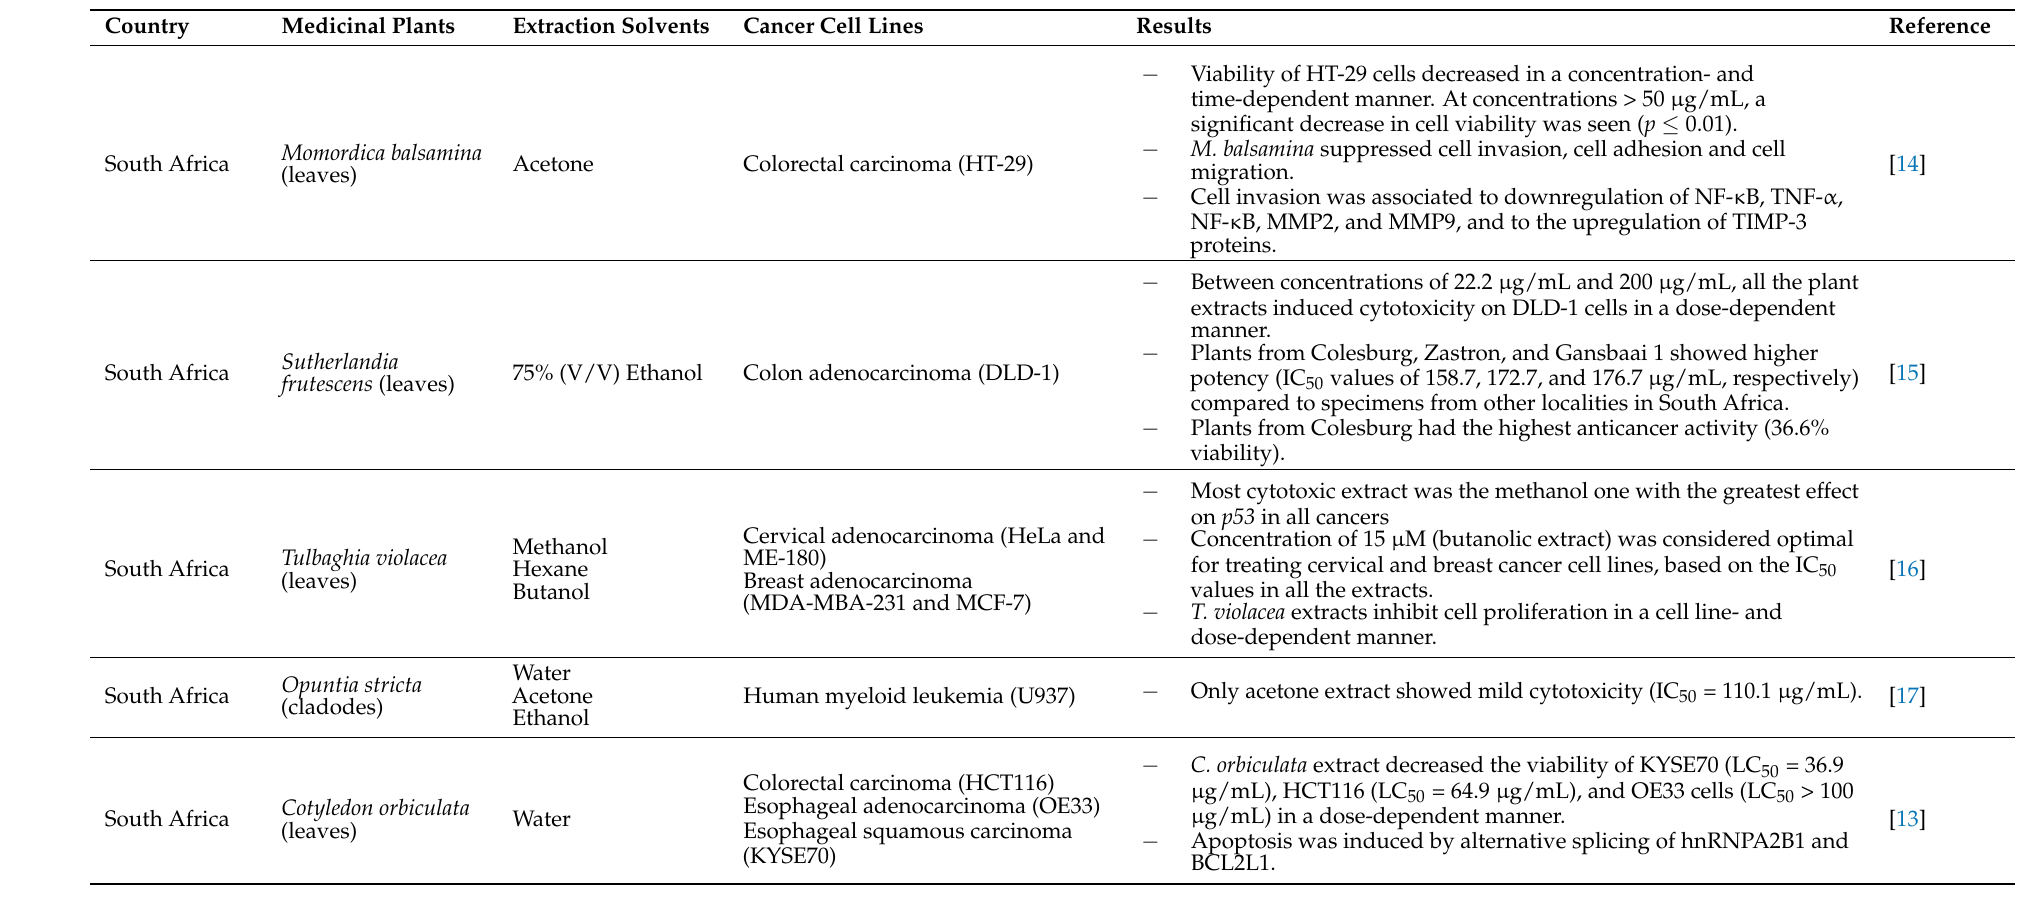
Table 1. In vitro cytotoxicity of extracts from medicinal plants collected from different countries in Africa against different cancer cell lines.